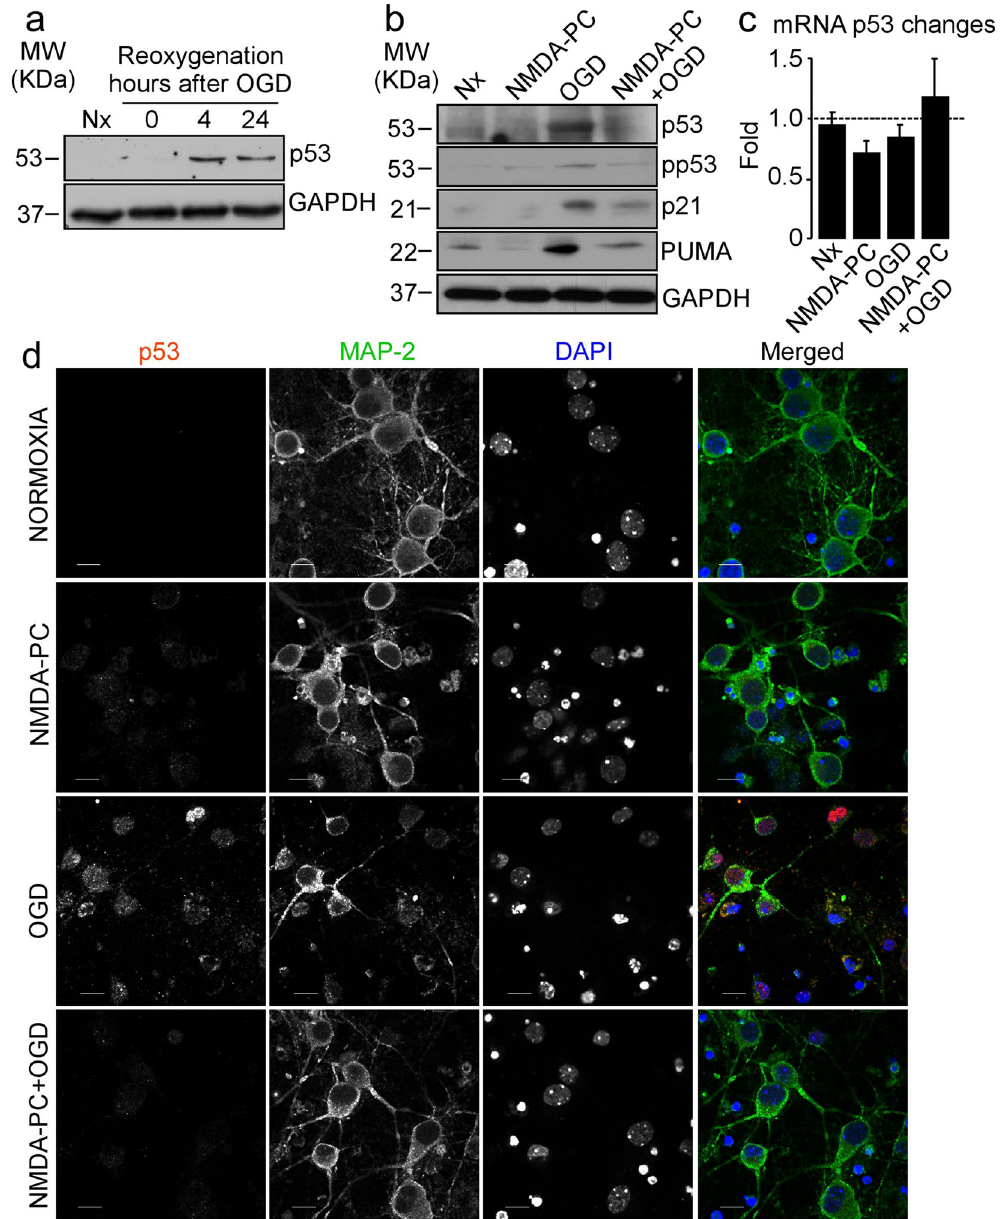
Figure 2. NMDA-PC promotes p53 destabilization throught a posttranslational mechanism. Mouse cortical neurons from fetal wild type (wt) or p53-null mice ( knockou t, ko) (9–10 DIV) were exposed to a validated in vitro model of NMDA-PC (Table 1). ( a ) OGD induced p53 stabilization at 4 hours after OGD. ( b ) OGD induced the accumulation of phosphorylated p53 form (pp53, Ser 15) and its targets p21 and PUMA as revealed by western blotting. GADPH protein levels were used as loading control. A representative western blot is shown out of four. ( c ) RT-qPCR analysis of p53 gene reveals that p53 mRNA remained unaltered after OGD. ( d ) Fluorescence microphotographs after immunostaining for p53 (in red) and Map-2 (in green) confirmed that NMDA-PC prevented the accumulation of p53 induced by OGD in neurons. Scale bar: 10 μ m. Relative percentages of neurons with p53-staining/Map-2-staining are presented in Supplementary Fig. S1. Relative protein abundances quantification Fig. 2a and Fig. 2b are presented in Supplementary Fig. S2 and that “full- length blots/gels are presented in Supplementary Fig.